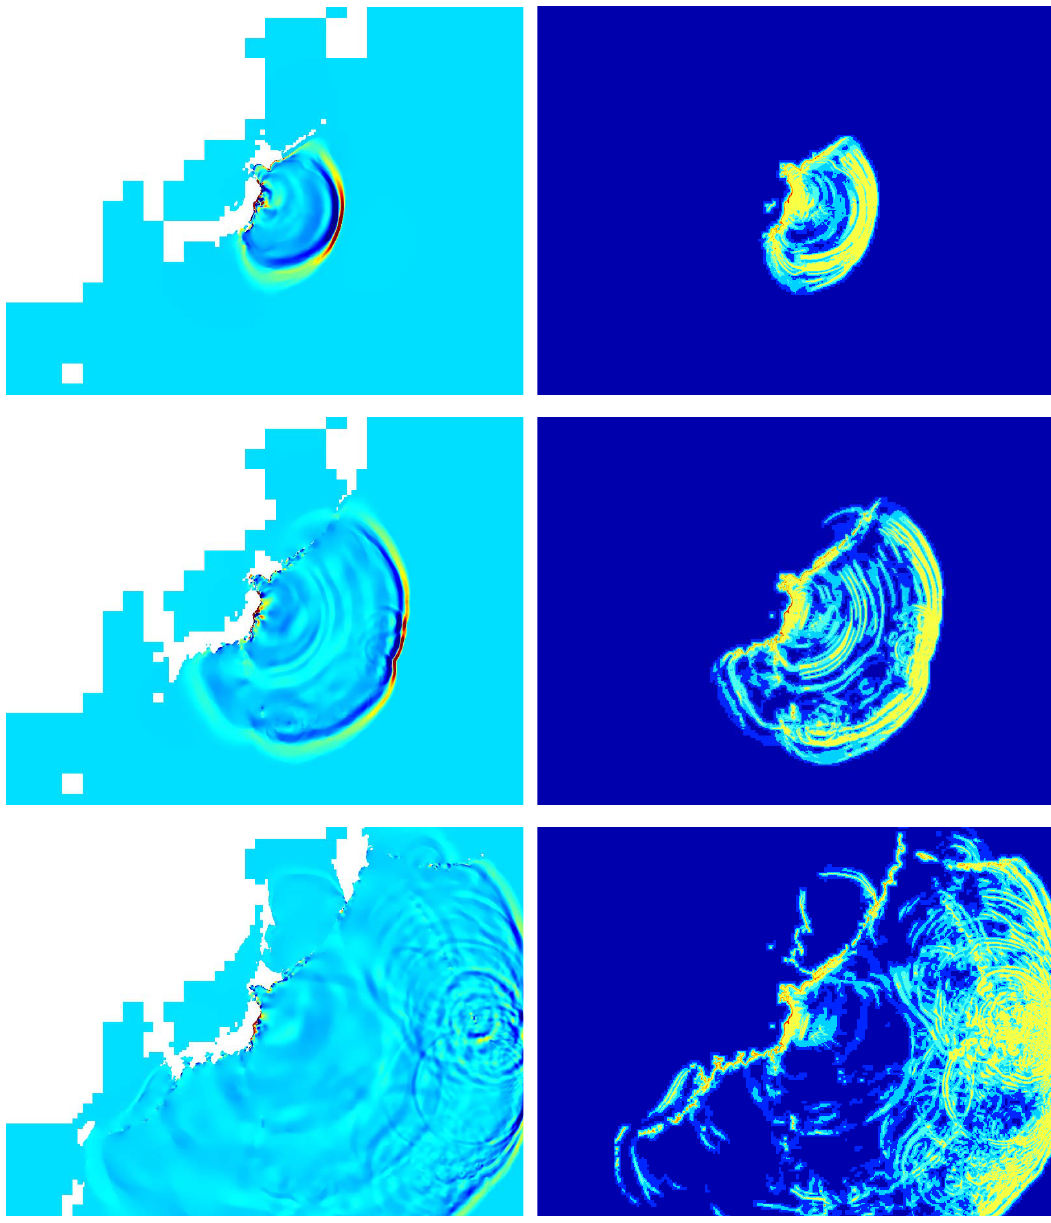
Fig. 6. Wave evolution over most of the modelled domain. Rows from top to bottom, t = 1 , 2 , 4h. Left column: evolution of wave elevation, dark blue < − 1m, dark red > 2m. Right column: corresponding evolution of spatial resolution, dark blue 5 levels, ≈ 2 . 3 ◦ , yellow 12 levels, ≈ 1arc-min, dark red 15 levels, ≈ 8arc-s, ≈